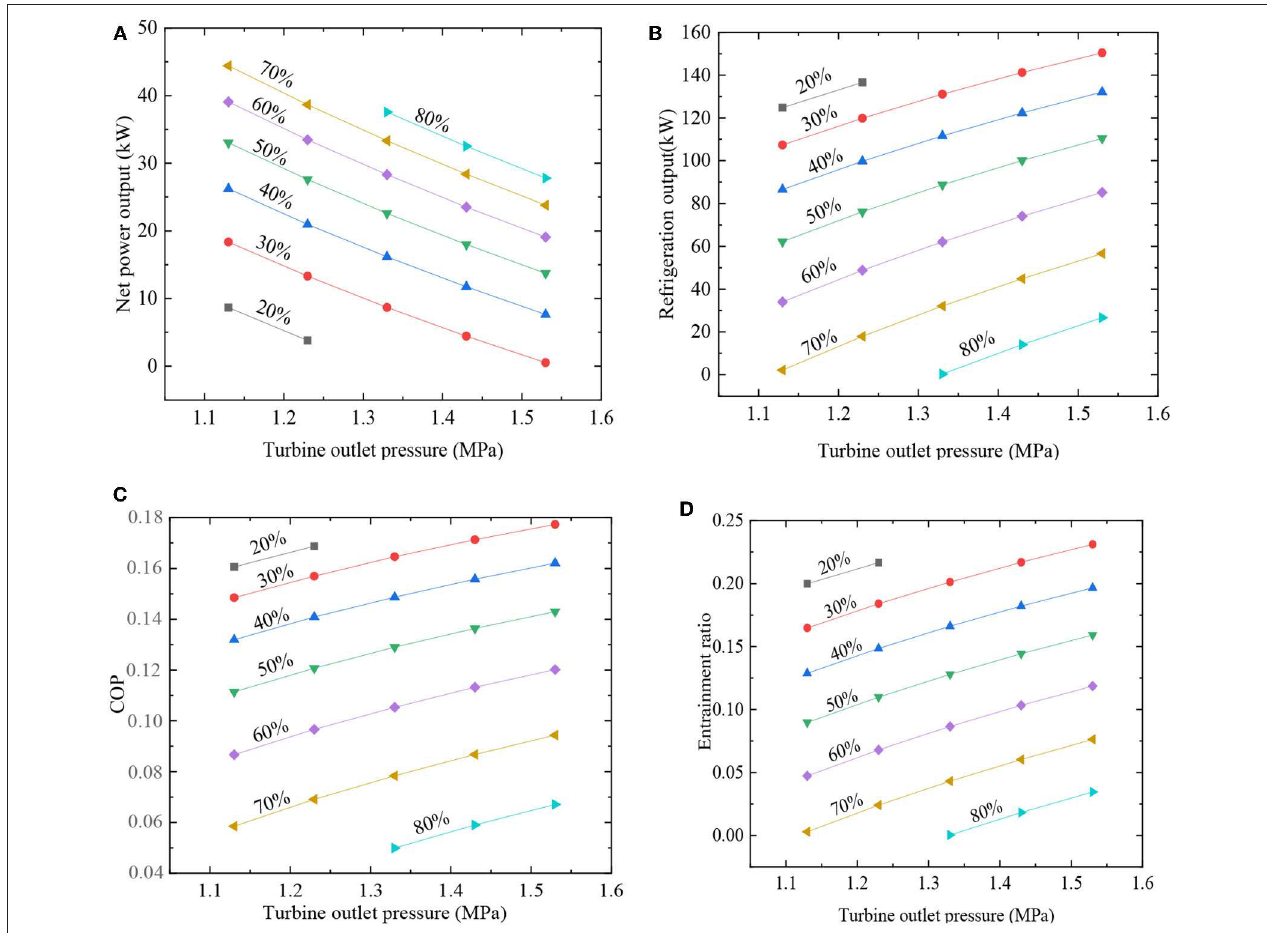
FIGURE 4 | Effect of turbine outlet pressure and mass fraction. (A) Net power; (B) refrigeration output; (C) COP; (D) entrainment ratio.